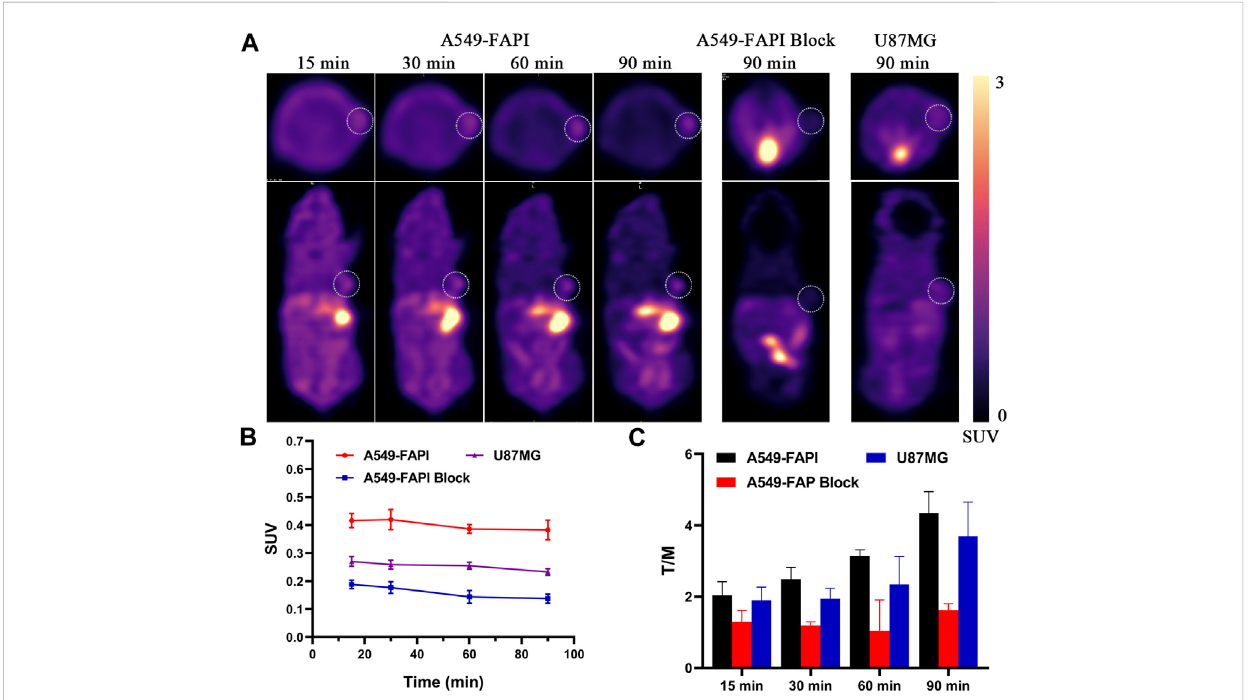
FIGURE 5 In vivo micro-PET imaging of FAP in tumors. (A) Static micro-PET images at all time points. (B) Tumor SUVs of [ 18 F] 3 in all subjects; white cycles indicate the tumor lesions, and the scale bars show SUV values. (C) Tumor/muscle ratios calculated from PET